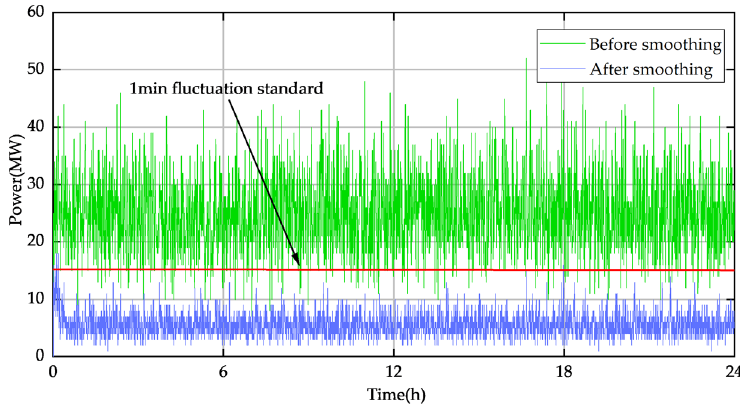
Figure 10. The wind power before and after smoothing.